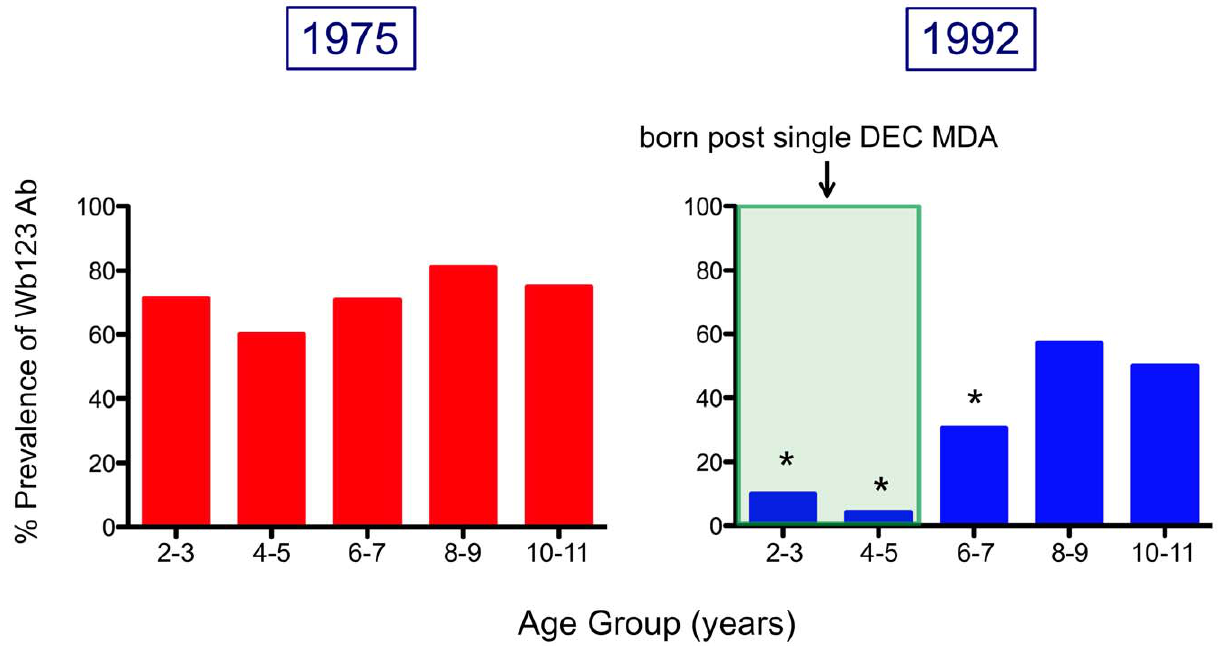
Figure 6. Prevalence of Ab to Wb123 in Children from 1975 and 1992. Prevalence of Ab to Wb123 (i.e. the percent positive for Ab) in children # 11 years old by 2 year age divisions in 1975 (left panel; red bars) and 1992 (right panel; blue bars). The shaded green area represents the period of time where children were born after island-wide treatment with DEC. Asterisks indicate a significant difference (p # 0.0045) by Fisher’s Exact test between identical age groups from both time periods.